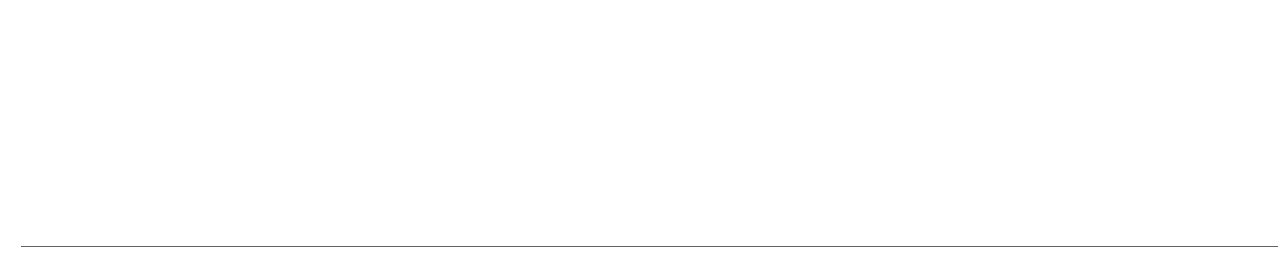
Frontiers in Neuroscience |